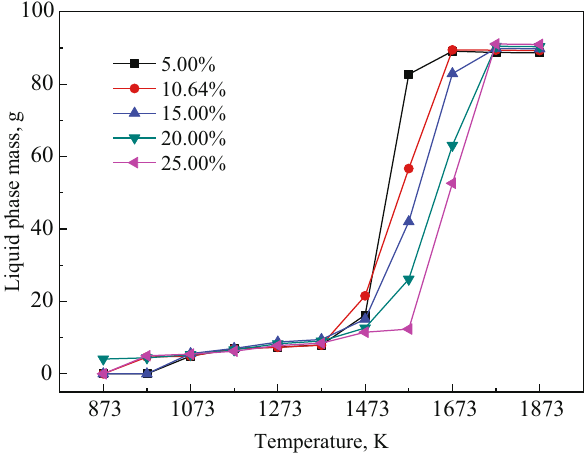
Figure 13: Relationship between liquid production and temperature under di ff erent Al 2 O 3 contents.